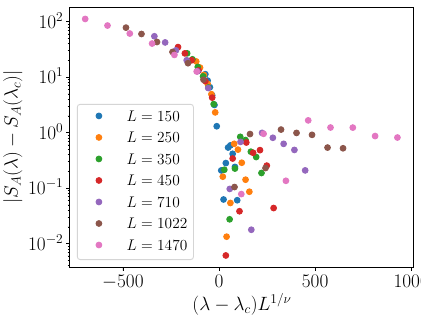
FIG. 9. Scaling collapse of the late-time entanglement entropy for the rotated circuit defined in Eq. (5). We use the scal- ing ansatz | S A (λ) − S A (λ c ) | = F [ (λ − λ c ) L 1 /ν ], where (λ c , ν) ≈ ( 0.64, 1.0 )